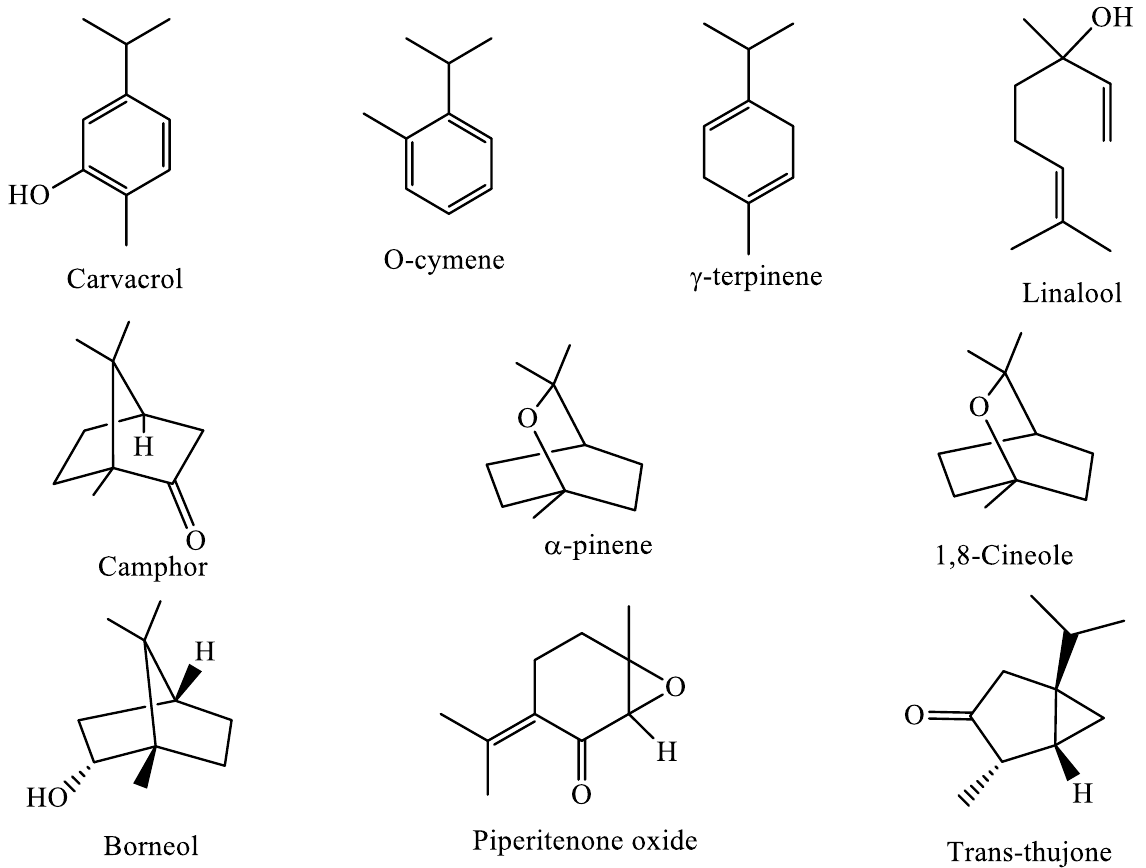
Figure 2. Chemical structures of the most abundant component of the three studied OEs